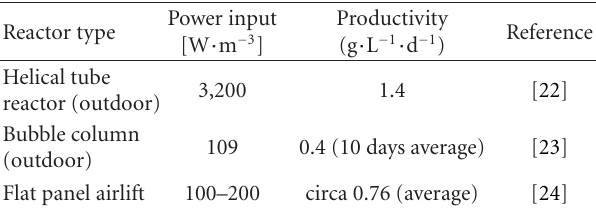
Table 5: Power input (excluding light) and algae biomass produc- tivity in dry matter per cultivation volume and day of di ff erent reac- tors in outdoor